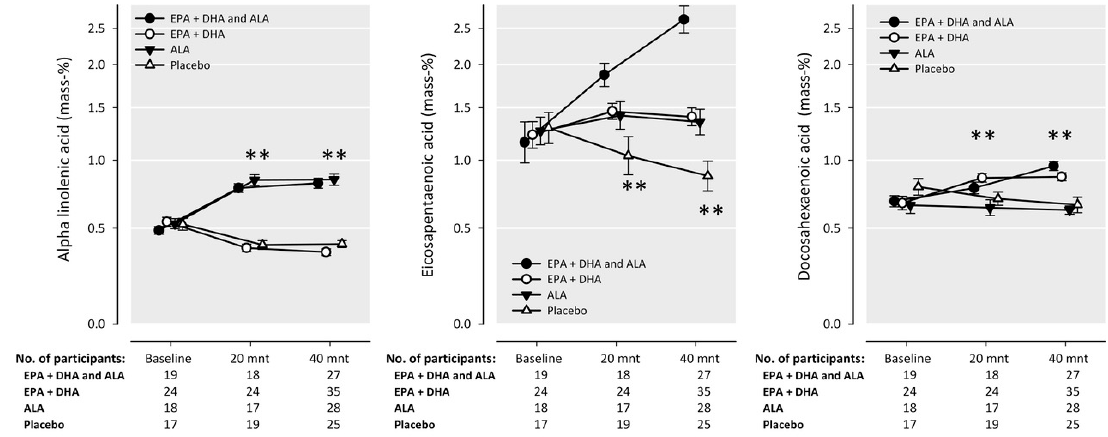
Figure 2. The effect of supplementation of n-3 fatty acids in margarines on serum cholesteryl ester biomarkers within Alpha Omega Trial participants included in the current analysis. Geometric mean values (expressed as mass percentage) with error bars indicating 95% confidence intervals, on a logarithmic scale. ** p < 0.01 between groups. Table 1. Baseline characteristics of 336 patients of the Alpha Omega Trial by treatment group with creatinine–cystatin C ‐ based eGFR< 60 mL/min/1.73 m 2 . EPA ‐ DHA and ALA ( n = 87)